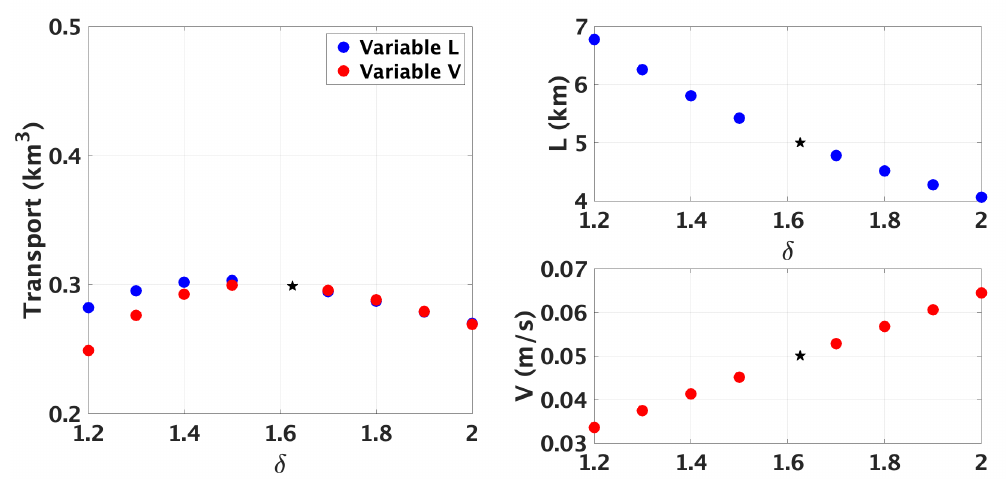
Figure 6. ( Left ) Cross-shelf transport across the surface Ψ = 0 for a variety of values of δ , as defined in Table 2. The blue data points correspond to changes in the denominator and red data points to changes in the numerator. ( Right, top ) Values of L corresponding to the values of δ used to derive the blue data points. ( Right, bottom ) Values of V corresponding to the values of δ used to derive the red data points. The black star in all panels shows the data point for the base case.